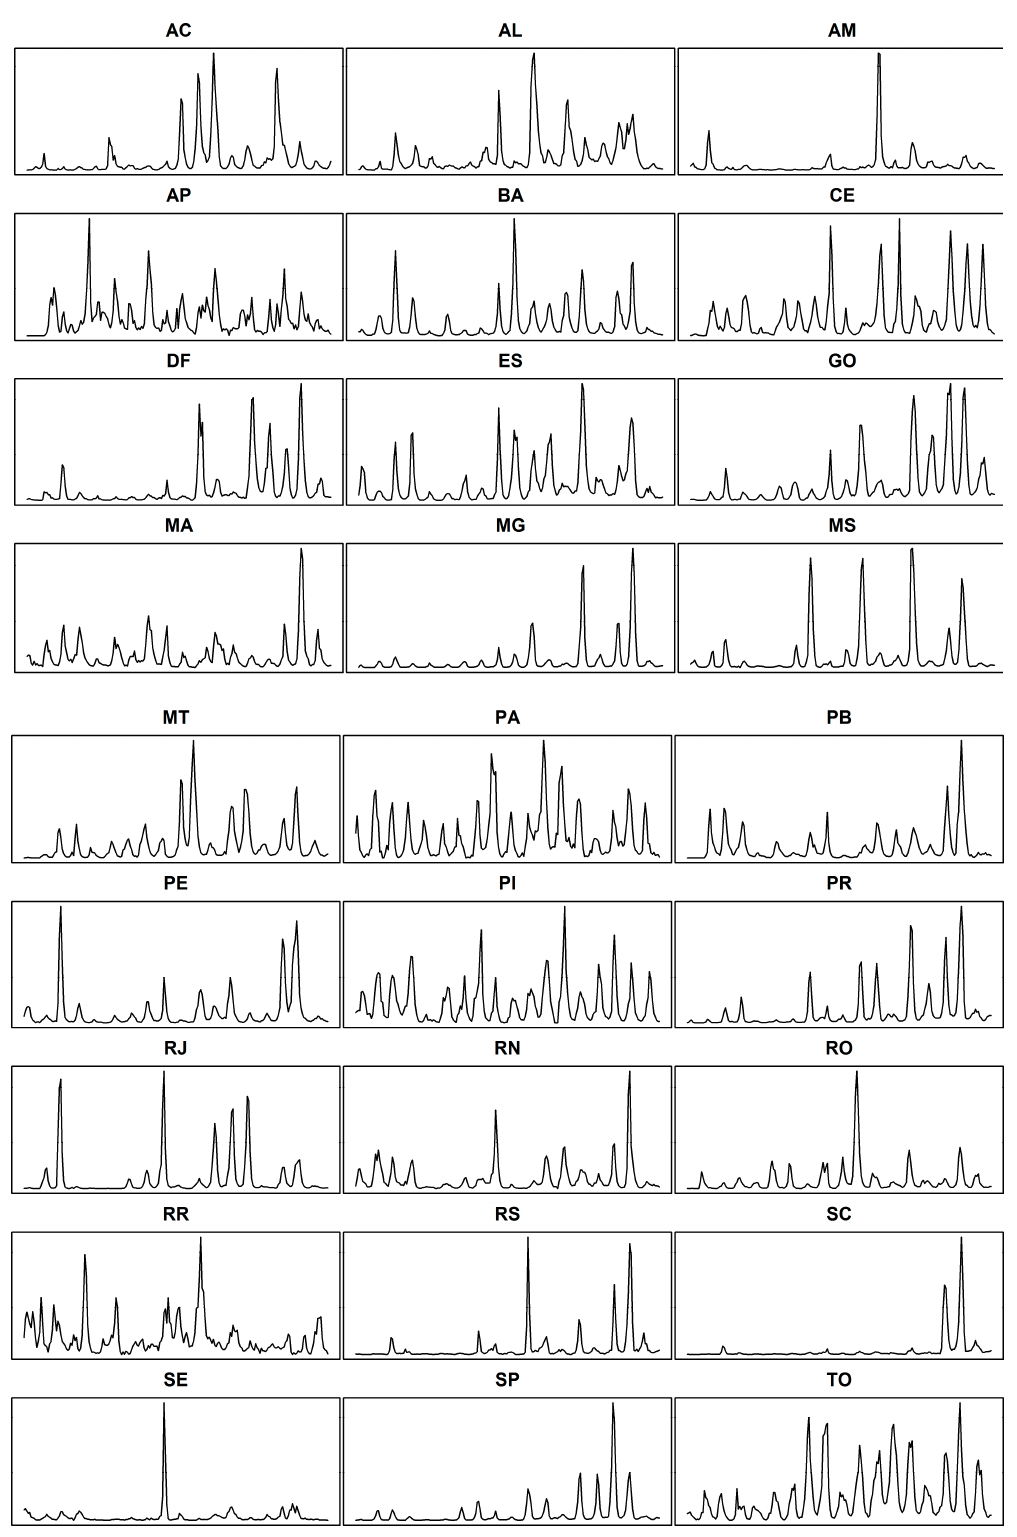
Figure 2. Time series of dengue cases in the states and federal district of Brazil from January 2000 to December 2017. Y -axis: number of monthly-dengue cases. X -axis: time period (January / 2000 to December /